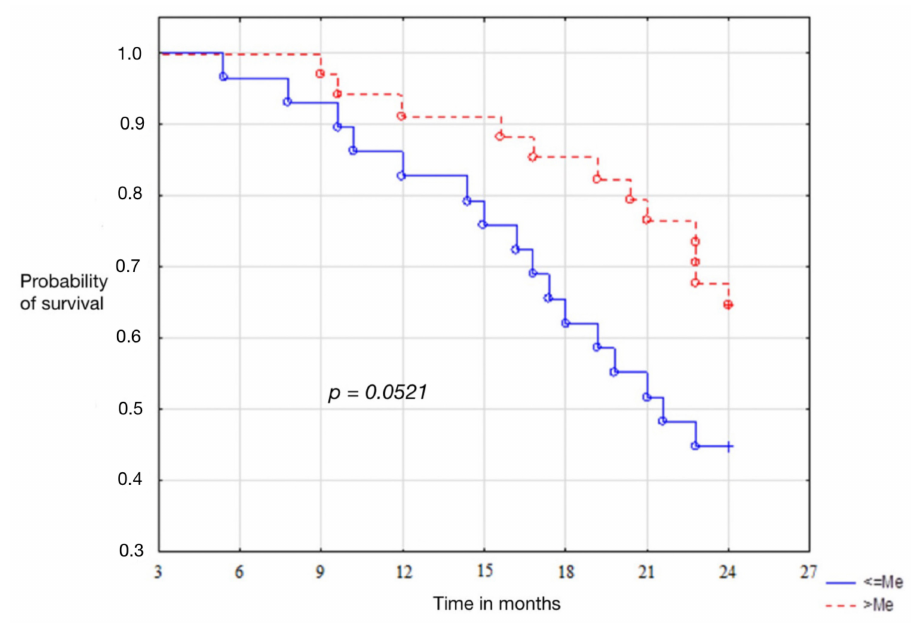
Figure 3. Kaplan-Meier curves for overall survival of patients with endometrial cancer.